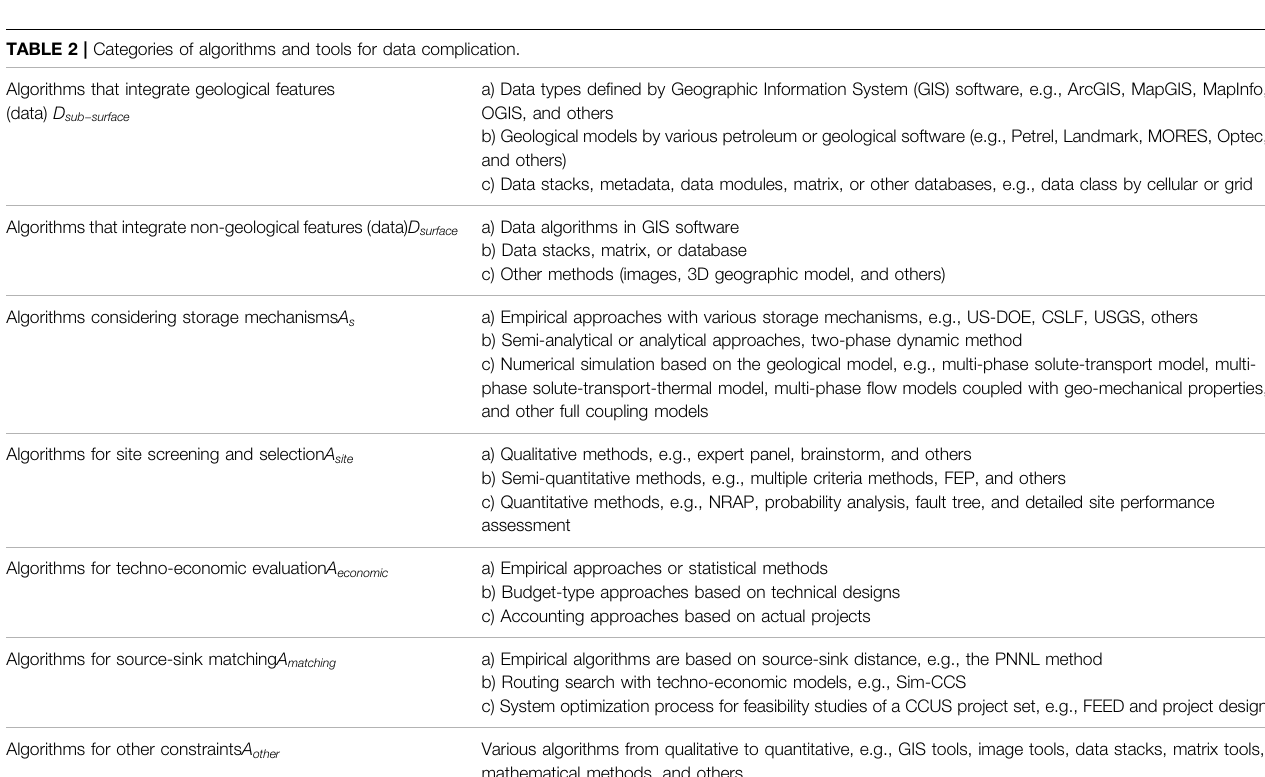
TABLE 2 | Categories of algorithms and tools for data